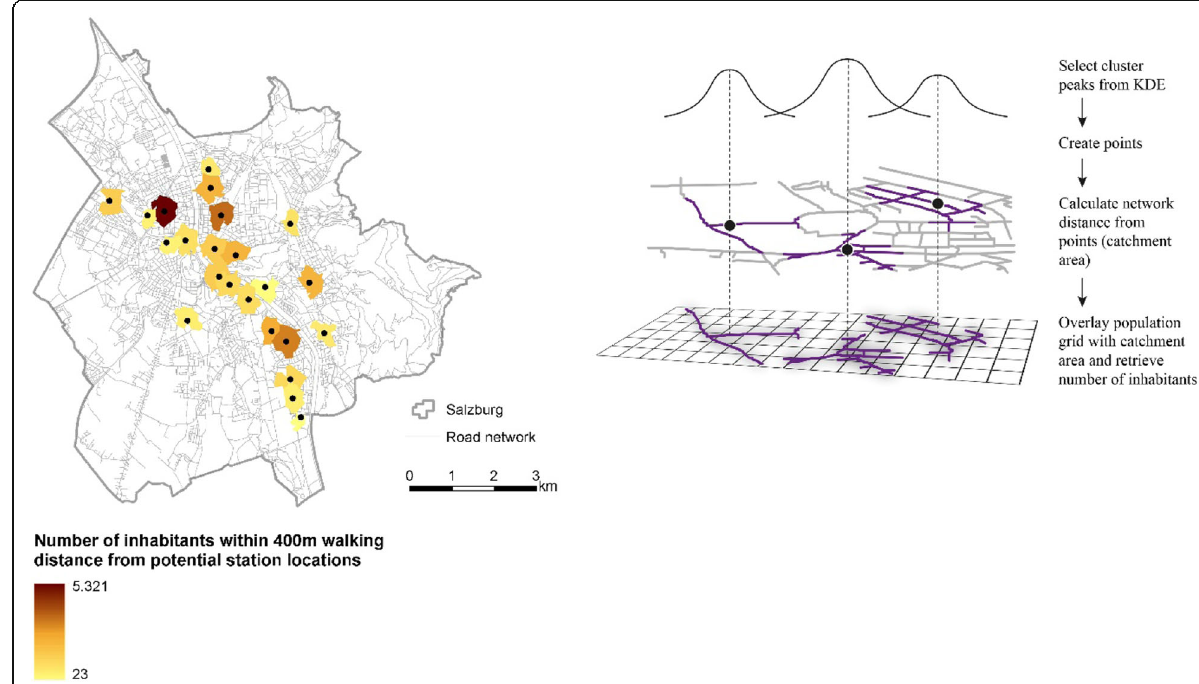
Fig. 7 Catchment area of 23 potential station locations with the number of inhabitants. The overlay analysis is described in the right part